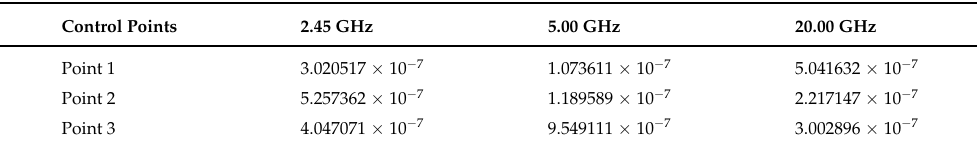
Table 8. Comparison of the reference solution versus the solution obtained in the GPU (fastest in single precision) for 2.45 GHz, 5.00 GHz, and 20.00 GHz frequencies, using the MSE. The values used for the error calculation are transferred every fixed number of iterations, as shown in Figure 11.